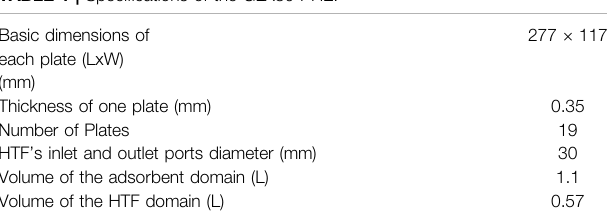
TABLE 1 | Speci fi cations of the GLX30